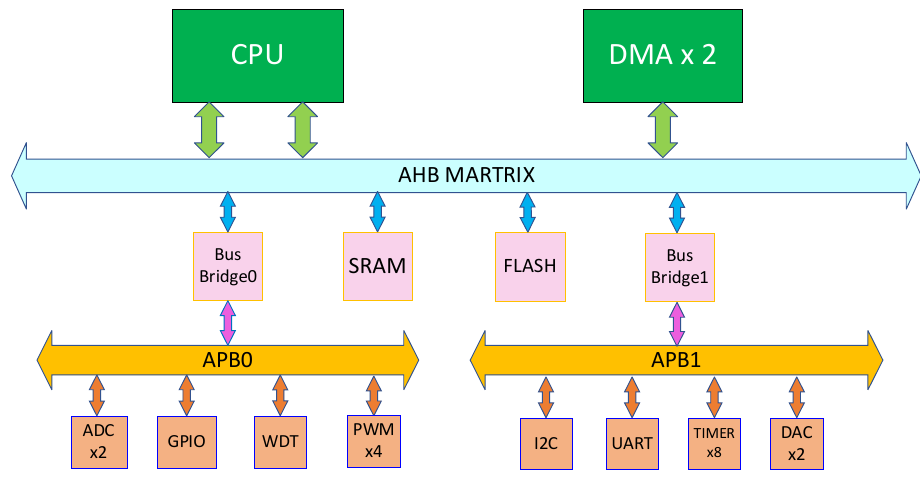
Figure 3. The architecture of universal SoC.